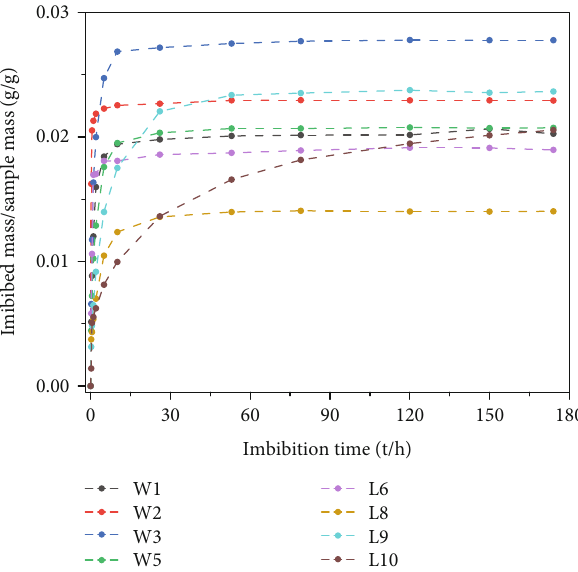
Figure 5: The imbibition proportion versus t of the deep Longmaxi Formation shale samples in NaCl solution with a salinity of Cl - of 15,000 mg/L.